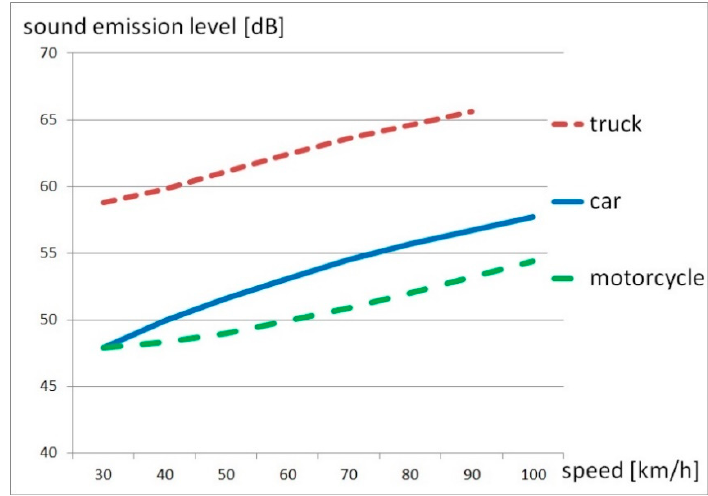
Figure 1. Comparison of the sound emission level according CNOSSOS ‐ EU [21] between motorcycles, cars and trucks on concrete asphalt.